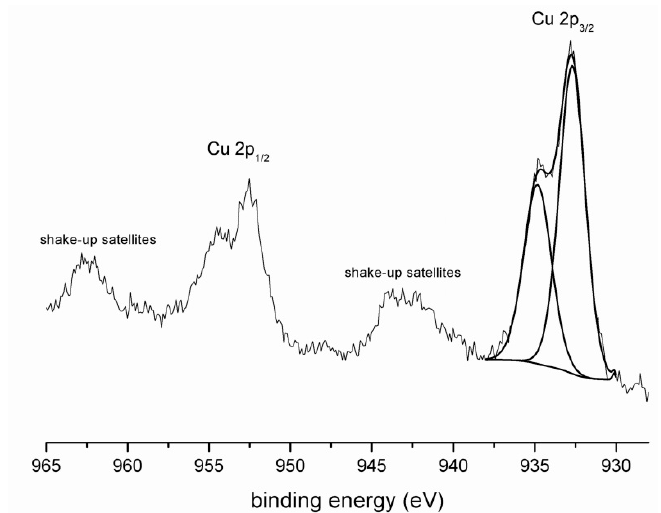
Figure 3. XPS spectrum of Cu.